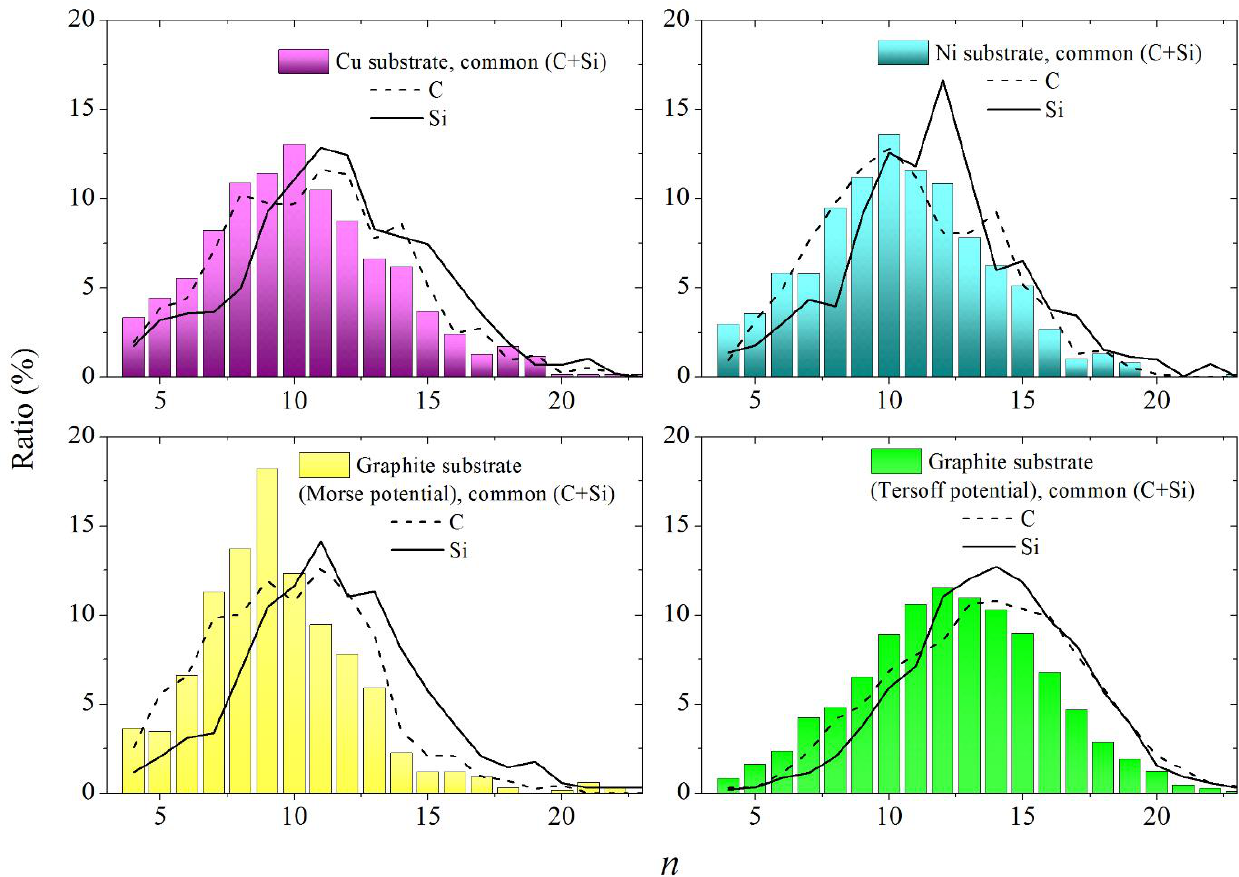
Figure 10. Distributions of Voronoi polyhedra over the number of faces obtained at the final stage of the SiC film deposition on various substrates, both for the entire SiC film and for its individual components (C and Si); the interaction between Si or C atoms and a graphite substrate was carried out using Morse and Tersoff potentials.